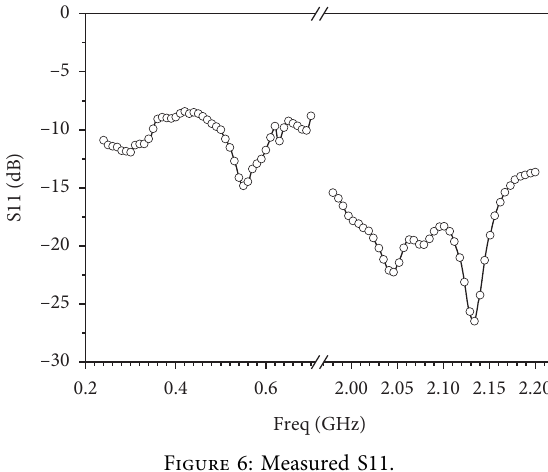
Figure 6: Measured S11.